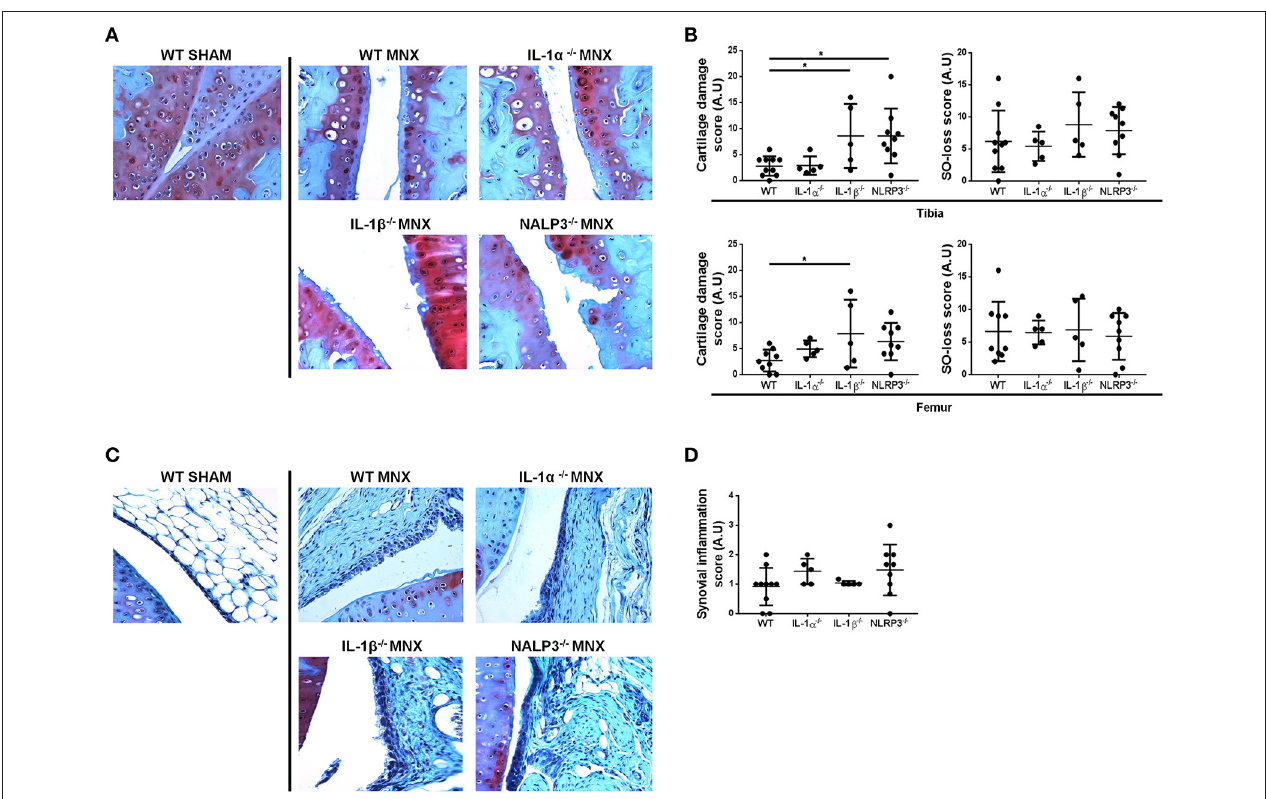
FIGURE 1 | IL-1 α − / − , IL-1 β − / − , and NLRP3 − / − mice develop OA features similar to WT mice after menisectomy. (A) Representative histologies, stained with Safranin-O, and (B) respective histological scoring of sham operated (WT SHAM) and menisectomized (WT MNX, IL-1 α − / − MNX, IL-1 β − / − MNX and NLRP3 − / − MNX) knee joint sections, at 8 weeks after surgery. Note the similar level of cartilage destruction and loss of proteoglycans in WT and IL-1 α − / − menisectomized knees, and exacerbated cartilage damage in IL-1 β − / − and NLRP3 − / − MNX mice. (C) Representative histologies, stained with Safranin-O, and (D) respective synovial inflammation scoring of sham operated and menisectomized knee joint sections. Note the similar level of synovial inflammation in mice of different genotypes. Mice number: WT MNX n = 10, IL-1 α − / − MNX n = 5, IL-1 β − / − MNX n = 5, and NLRP3 − / − MNX n = 9. * p <